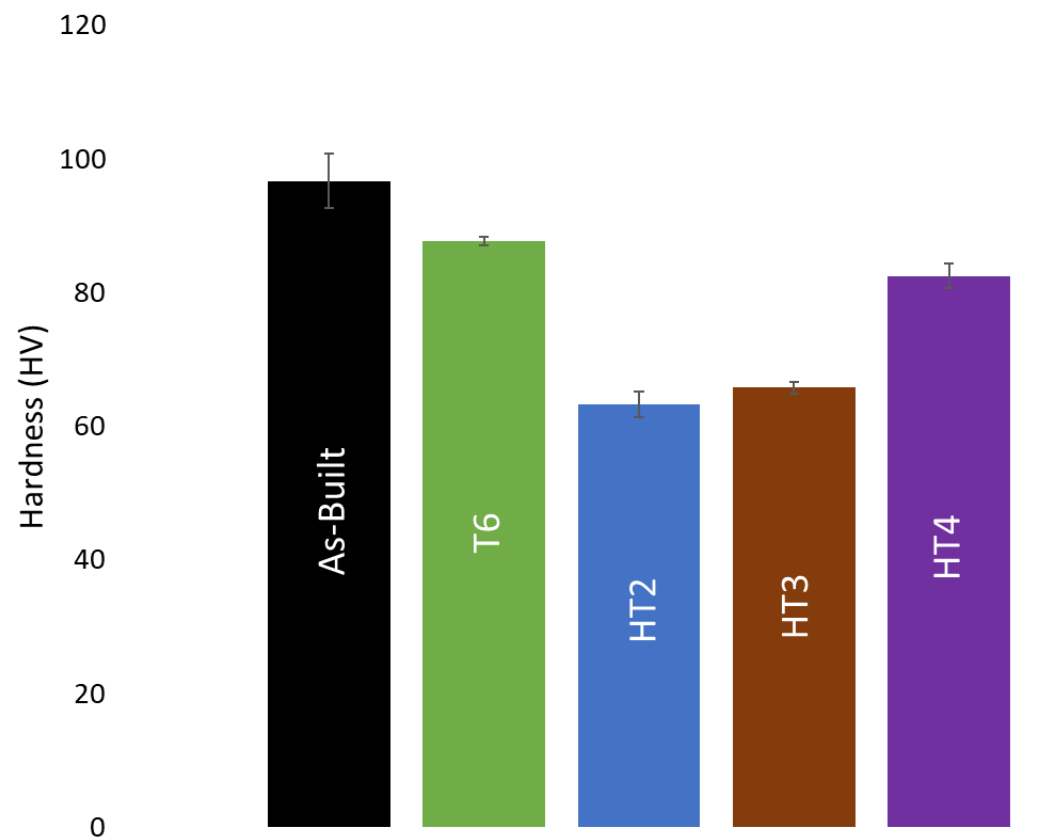
Figure 5. Vickers hardness of as-built, T6, HT2, HT3 and HT4. As-built shows the highest hardness, HT2 shows the lowest hardness. Values shown are a mean out of three